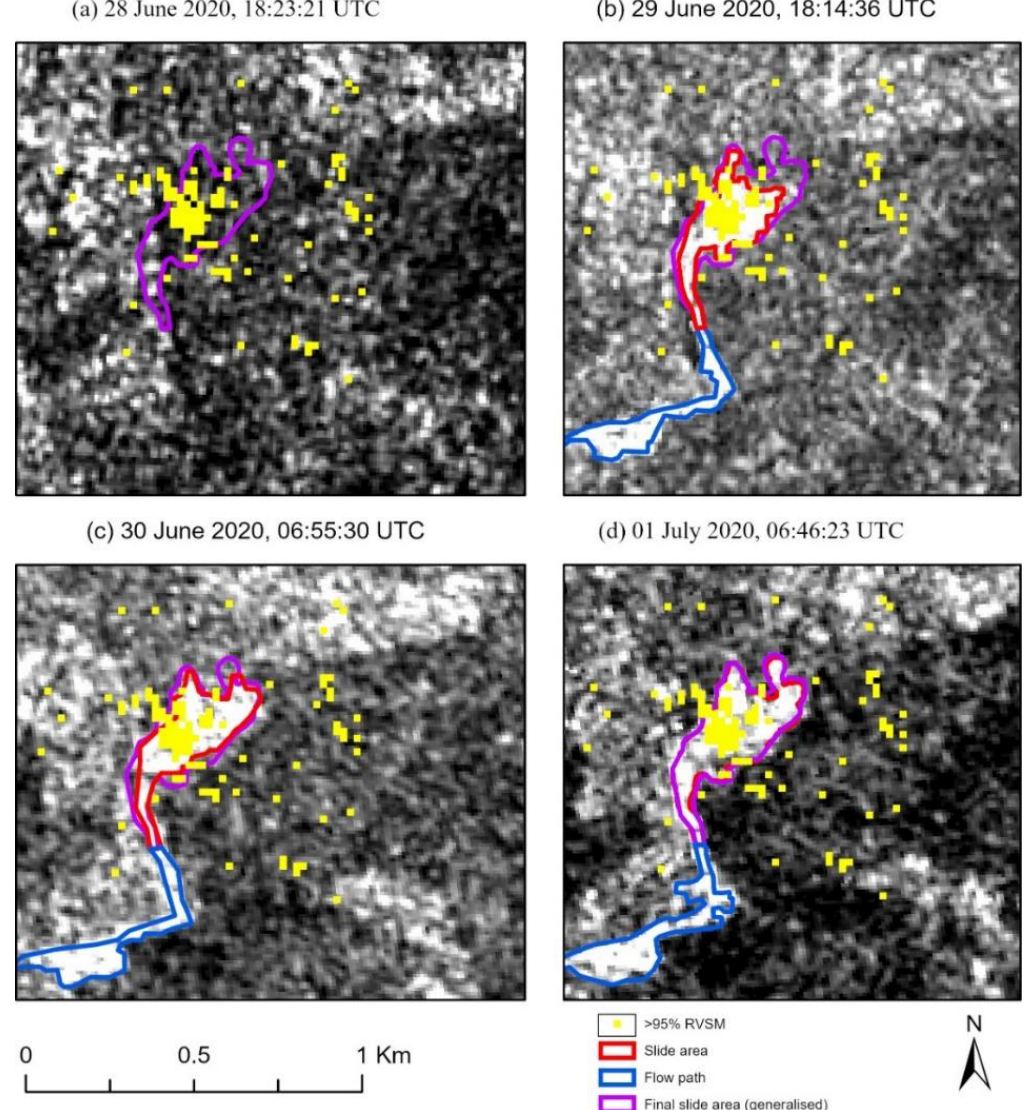
Figure 8. VV polarised ESA Sentinel 1 synthetic aperture radar amplitude illustrating the progression of the Shass Mountain landslide relative to areas of high RVSM: (a) pre landslide on 28 June; (b) 29 June; (c) 30 June; and (d) 01 July 2020. The area of high RVSM is the area exceeding the 95 th percentile derived from MSSA data 1–6 months prior to the